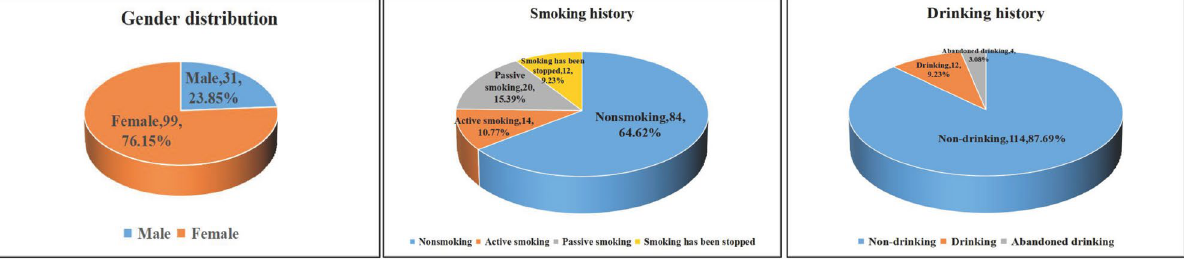
Figure 2. Descriptive characteristics of the study population.